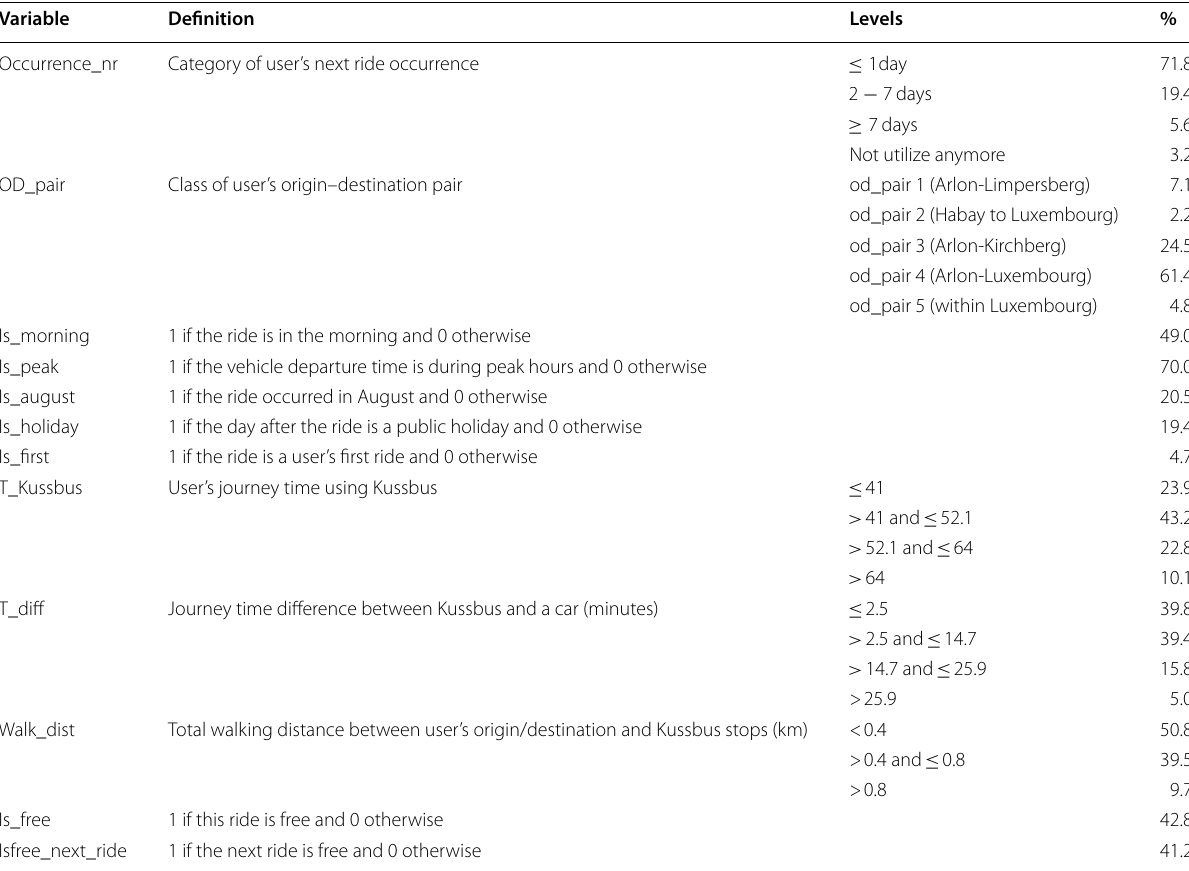
Table 3 Description of the key variables of the discrete BN (N